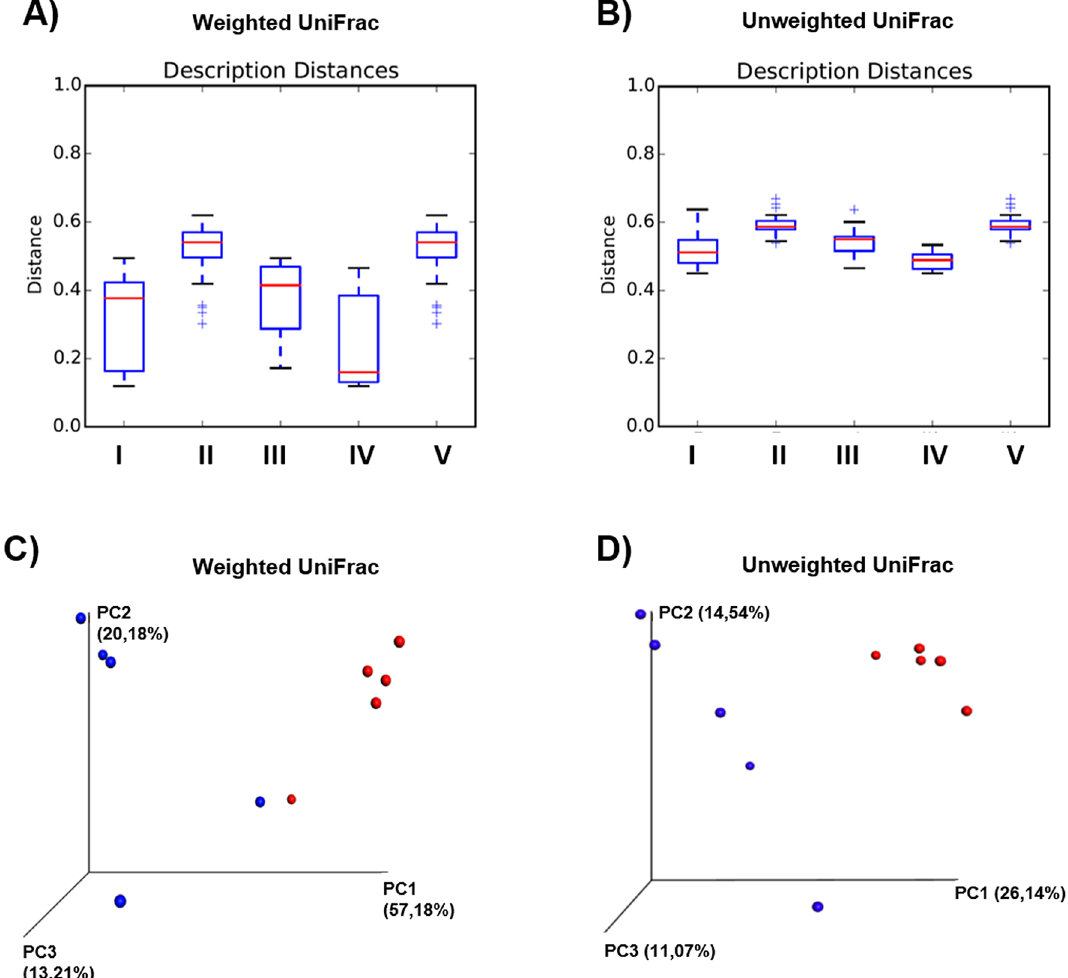
Figure 1. β-diversity analysis of the gut microbiota between ZIKV-infected and uninfected mice. Distance boxplots of weighted ( A ) and unweighted Unifrac ( B ): I—All within the description, II—All between description, III—Uninfected vs. Uninfected, IV—ZIKV vs. ZIKV, and V—Uninfected vs. ZIKV. ( C ) PCoA plot weighted Unifrac and ( D ) PCoA plot unweighted Unifrac, blue: Uninfected, red: ZIKV. Significance was tested using a two-sided Student’s two-sample t-test; the non-parametric p-values were calculated with Bonferroni correction. p-values for comparisons of Distance boxplots ( A ): I vs. II p = 0.010, I vs. III p = 1, I vs. VI p = 1, I vs. V p = 0.010, II vs. III p = 0.010, II vs. IV p = 0.010, II vs. V p = 1, III vs. IV p = 0.420, III vs. V p = 0.010, and IV vs. V p = 0.010; ( B ): I vs. II p = 0.010, I vs. III p = 1, I vs. VI p = 1, I vs. V p = 0.010, II vs. III p = 0.010, II vs. IV p = 0.010, II vs. V p = 1, III vs. IV p = 0.080, III vs. V p = 0.030, and IV vs. V p =